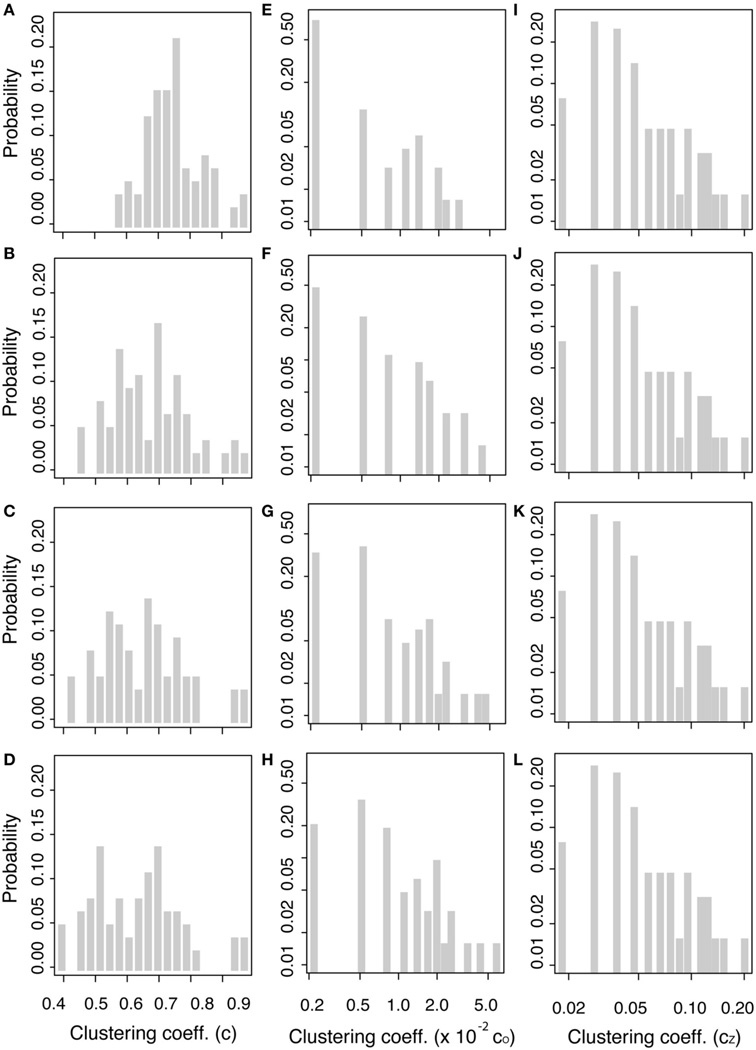
Clustering coefficient distributionsBinary clustering coefficient at threshold: 0 (A), 25 (B), 50 (C), and 125 (D). Weighted clustering coefficient, cO (see Equation 9),at threshold: 0 (E), 25 (F), 50 (G), and 125 (H) and weighted clustering coefficient, cz (see Equation 10),at threshold: 0 (I), 25 (J), 50 (K), and 125 (L).